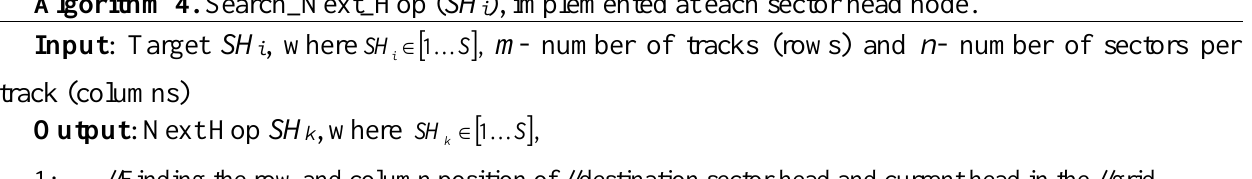
Algorithm 4. Search_Next_Hop ( SH i ), implemented at each sector head